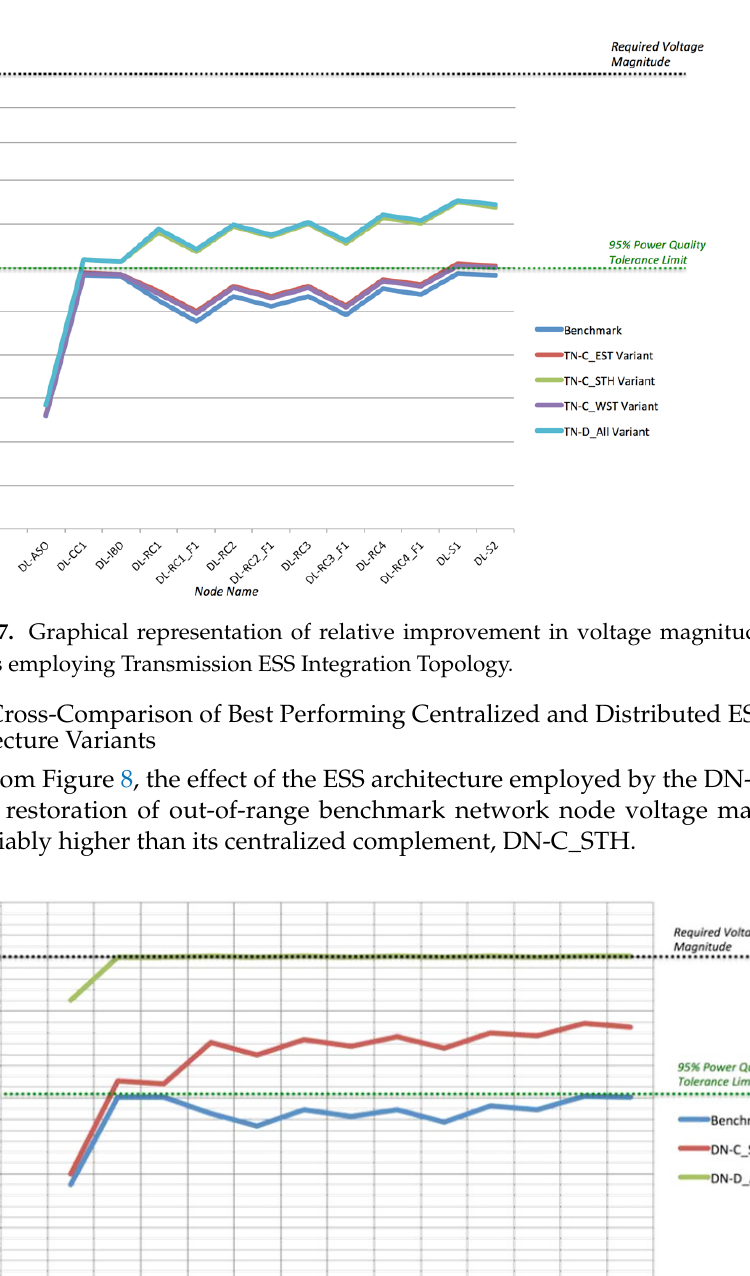
Figure 8. Graphical Representation of Relative Improvement in Voltage Magnitude between Top Centralized and Top Distributed ESS Integration Architecture Variants.